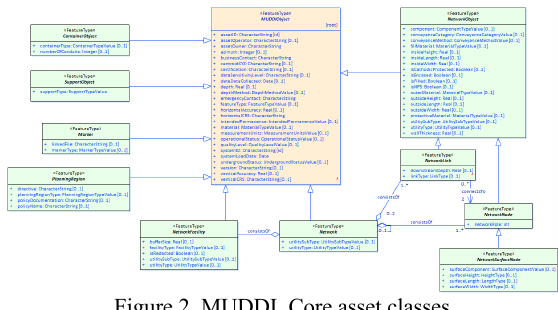
Figure 2. MUDDI_Core asset classes